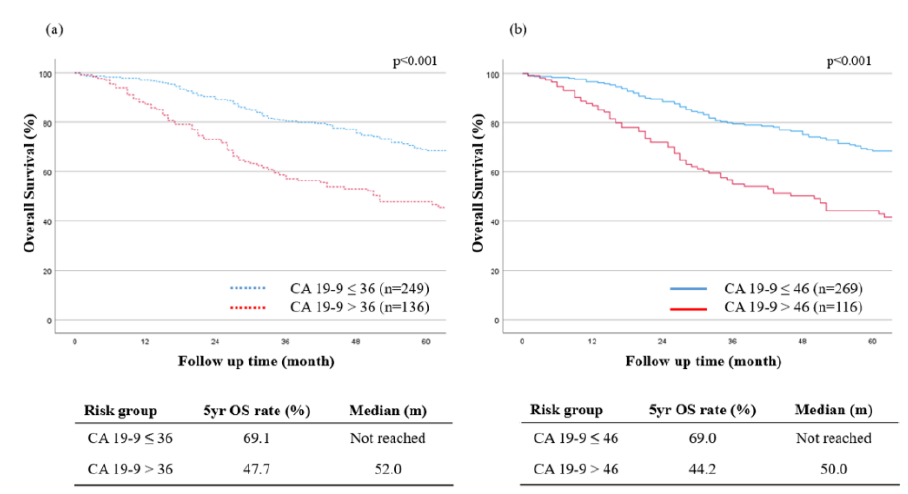
Figure 3. Overall survival according to ( a ) CA 19-9 level 36 U/mL and ( b ) level 46